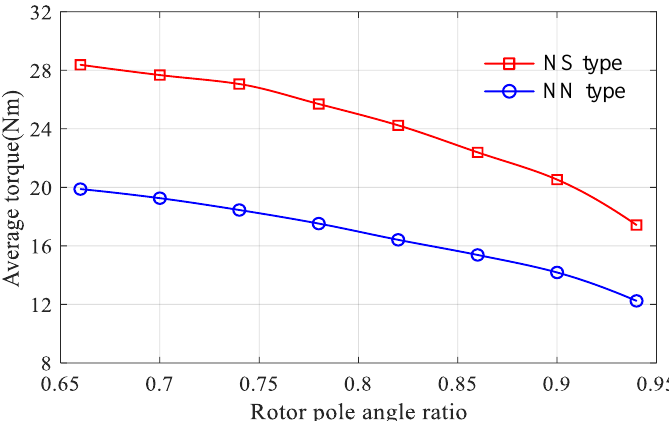
Figure 4. Influence of rotor pole angle on average torque.